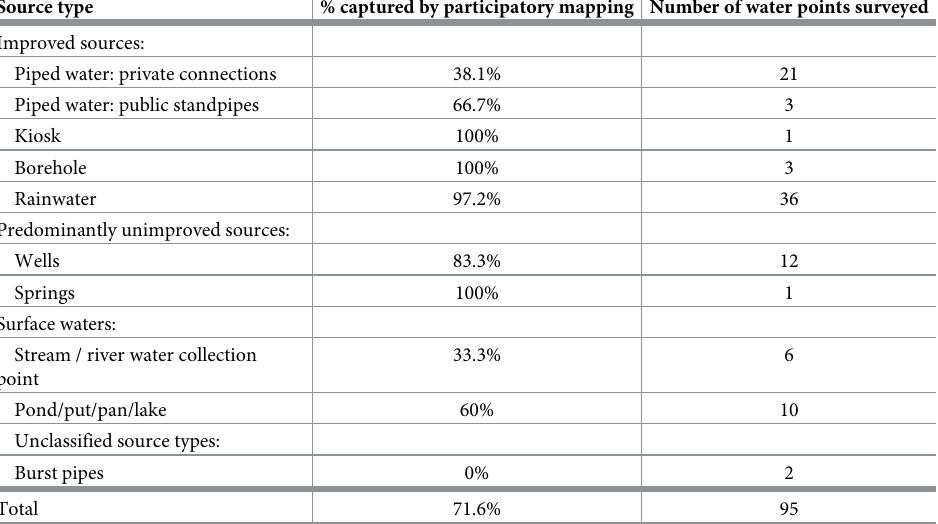
Table 4. Proportion of water points in source survey captured (i.e. with a corresponding point of the same type within 115 metres) through participatory mapping, by source type. Source